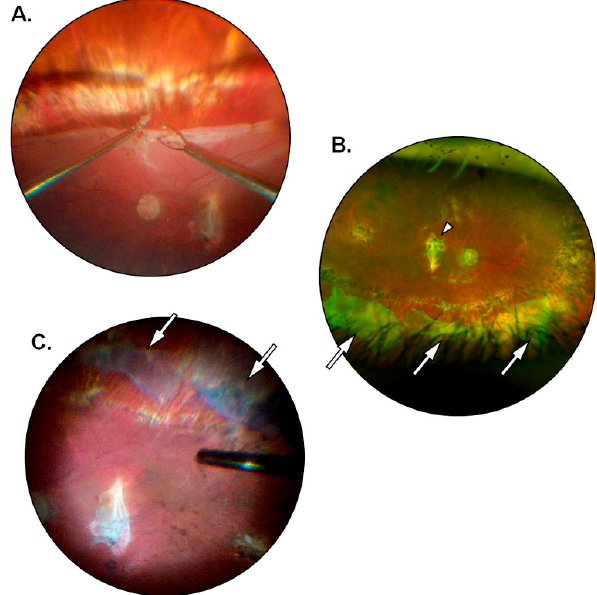
Figure 2. Management of a peripheral retinectomy with hAMP-V. ( A ) Intraoperative visualization of the surgeon performing an inferior peripheral retinectomy extending over three quadrants. ( B ) Postoperative fundus image at 1 month from hAMP-V showing three large hAM patches applied near the retinectomy margins (arrows) and coating a wide area of exposed EPR; the vitreous cham- ber is filled with silicone oil and a large macular scar can be seen (arrowhead). ( C ) Intraoperative visualization of the hAMs after silicone oil removal showing the non-fibrotic margins of the retinec- tomy with pigmented laser scars; the patches underwent minor folding of the edges and acquired a blue tinting due to the injection of vital dyes (arrows).